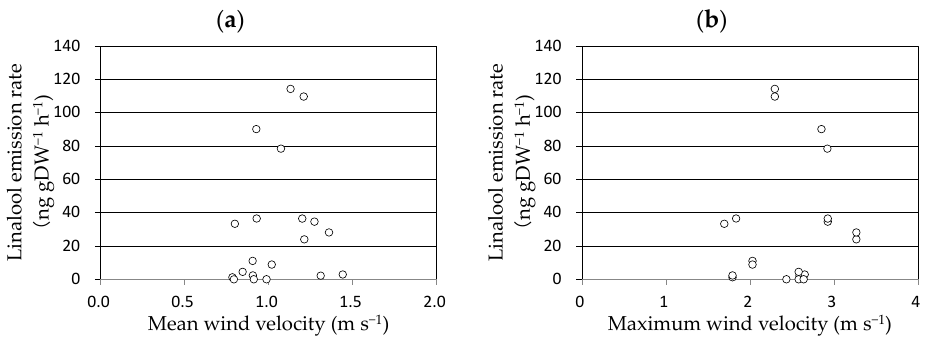
Figure 3. Relationships between linalool emission rate of rice against mean ( a ) and maximum wind velocity ( b ). The mean wind velocity was averaged for 2 h between 2 and 4 h before the measurements. The maximum wind velocity was the maximum value of 1 min averages recorded 2–4 h before the measurements.